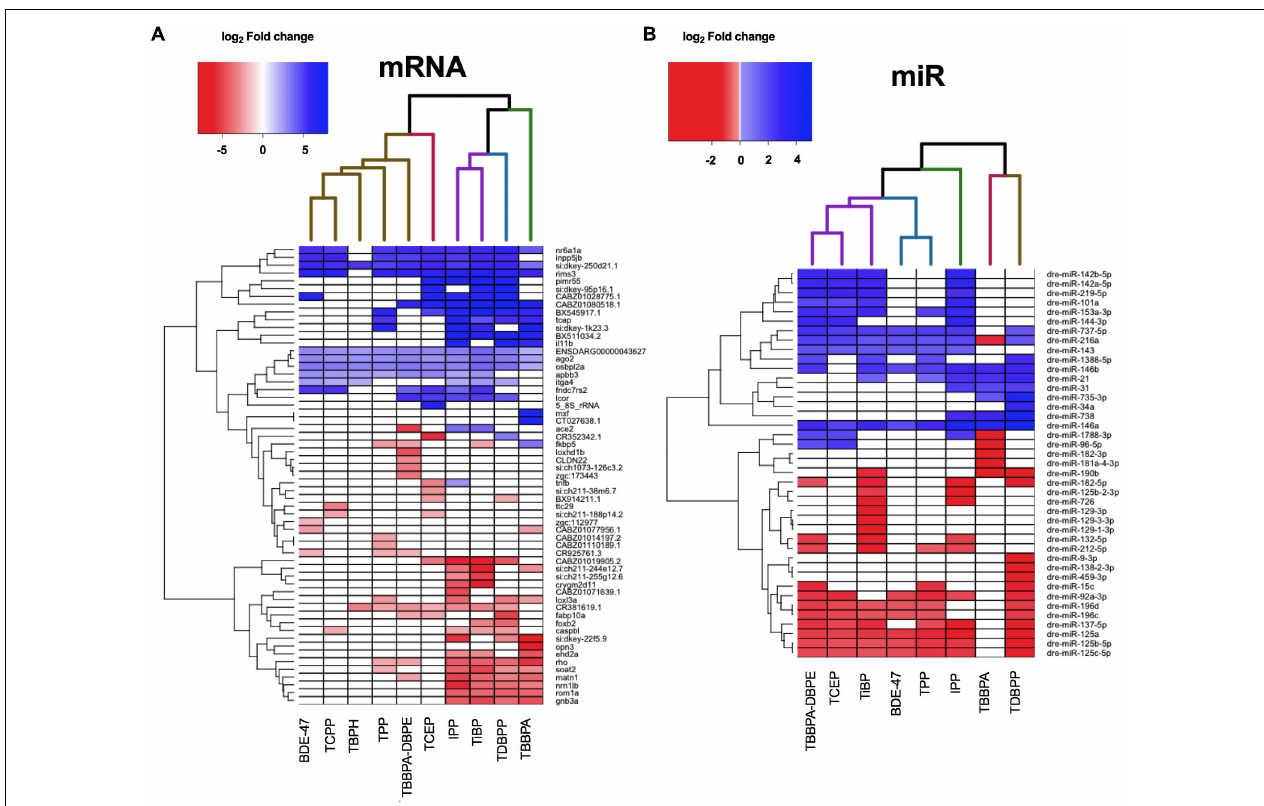
FIGURE 4 | Heatmap representing log 2 fold changes of (A) top mRNAs and (B) top miRs across FRCs. Up to 5 genes with highest increase and decrease in mRNA or miR expression levels were selected and their fold changes were plotted for all FRCs. Each column dendrogram color represents a cluster.